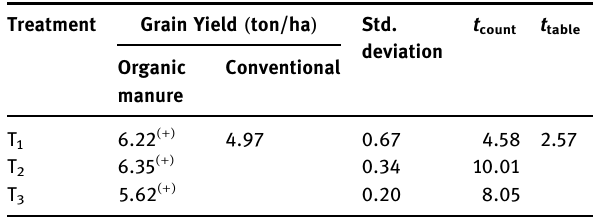
Table 3: Number of tillers Varieties Treatments Average of